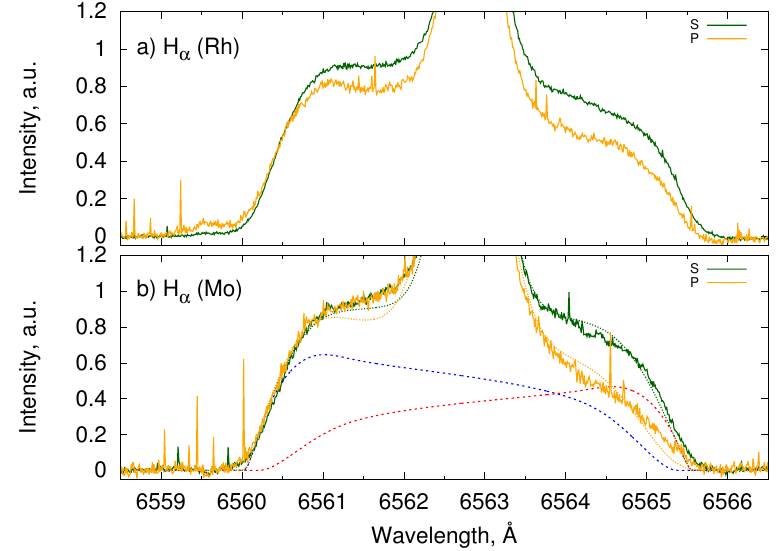
Figure 11. Polarization by light reflection in the line shapes of Balmer- α in front of Rh ( a ) and Mo ( b ) mirrors. The applied potential was − 100 V, and the spectra were measured at the angle of 70 ◦ , as shown in Figure 4. The spectra measured with the direction of polarization perpendicular to the plane of incidence are shown using the green line ( S ) and with the direction of polarization parallel to it as the orange line ( P ). The modeling of the Mo spectra is shown using the dotted green ( S polarization) and orange ( P -polarization) lines. The blue- and red-shifted components of the S -polarization spectrum are shown using the dashed blue- and red-shifted lines. The experimental data and results of the modeling for Mo are taken from [18]. The constant background was subtracted from the spectra, and normalization factors were introduced to show the spectra in the same